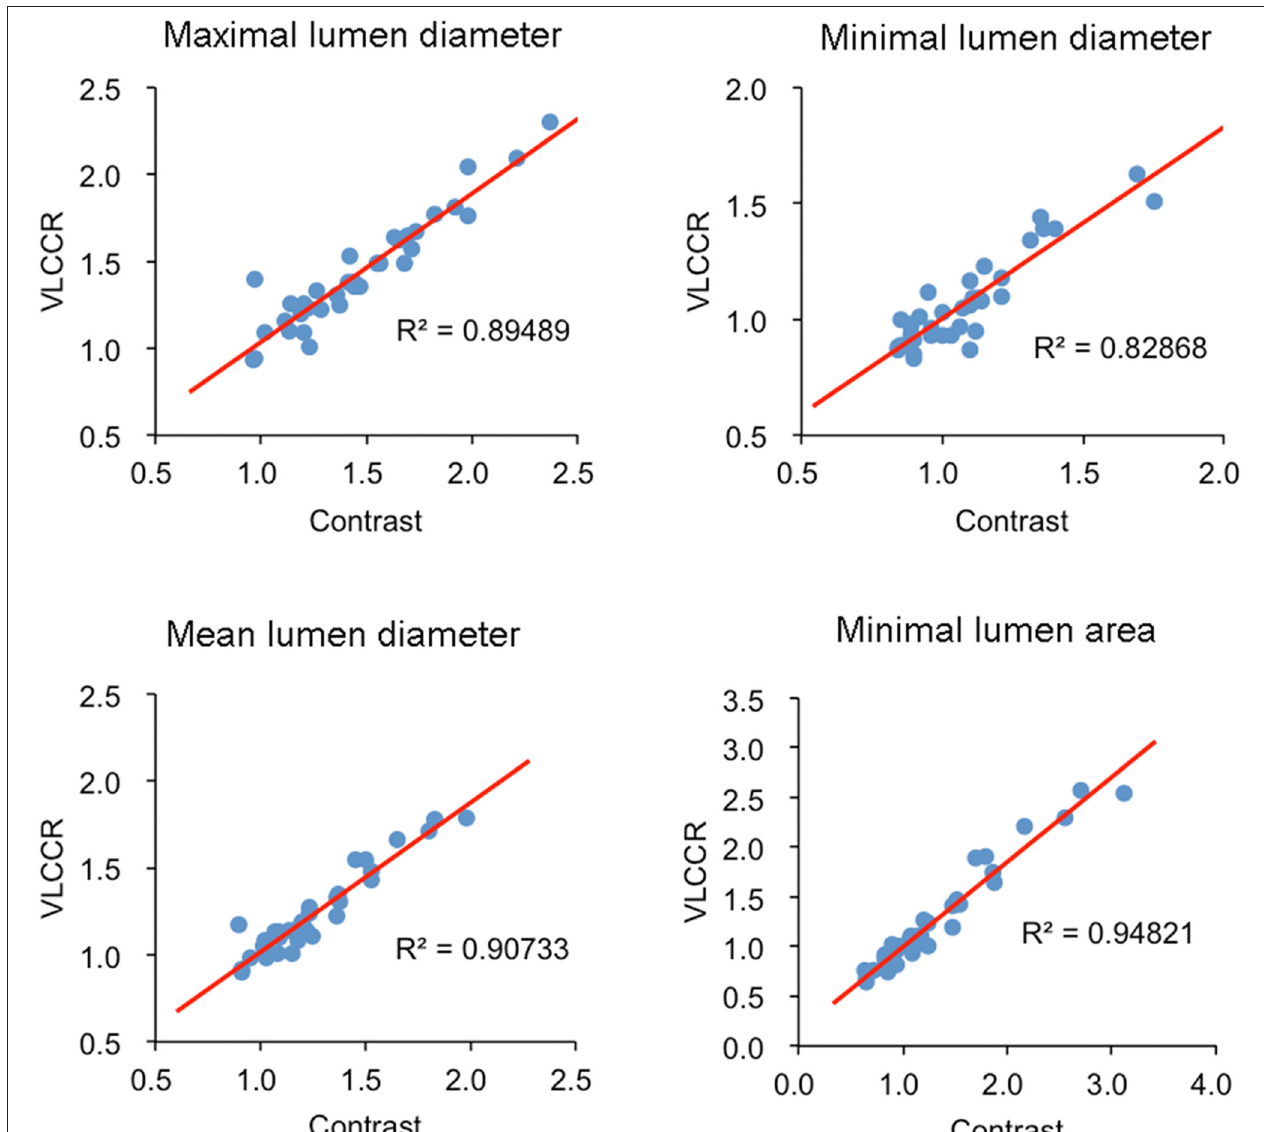
FIGURE 4 | Correlations of MaxLD, MinLD, Mean LD, and MLA between contrast medium and VLCCR groups.